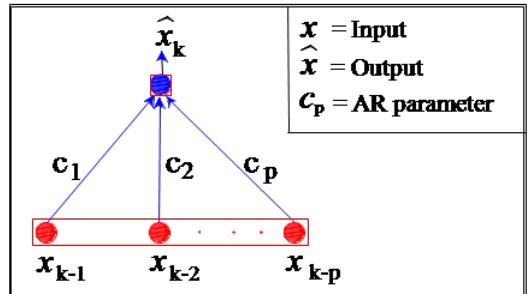
Figure 2. Autoregressive (AR)